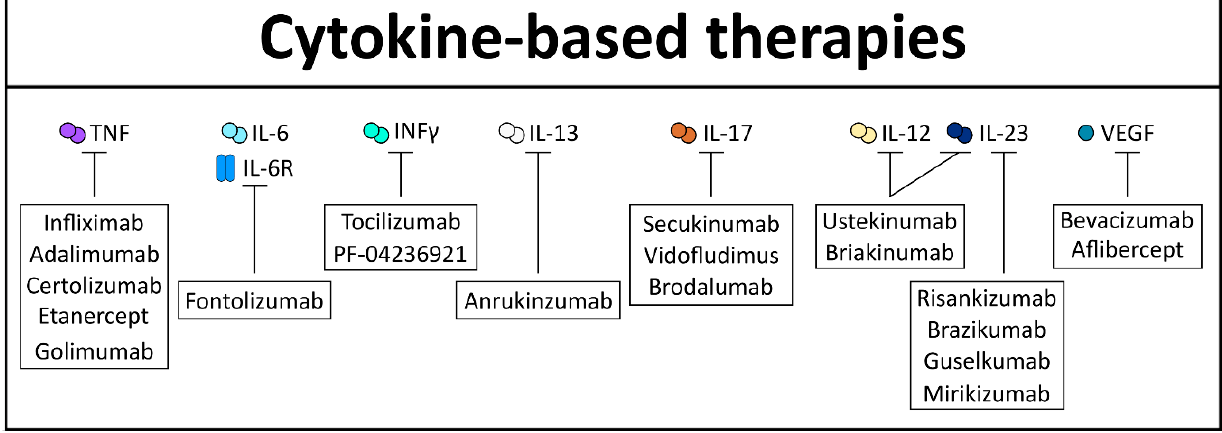
Figure 5. Monoclonal antibodies developed for targeting cytokines in intestinal diseases.